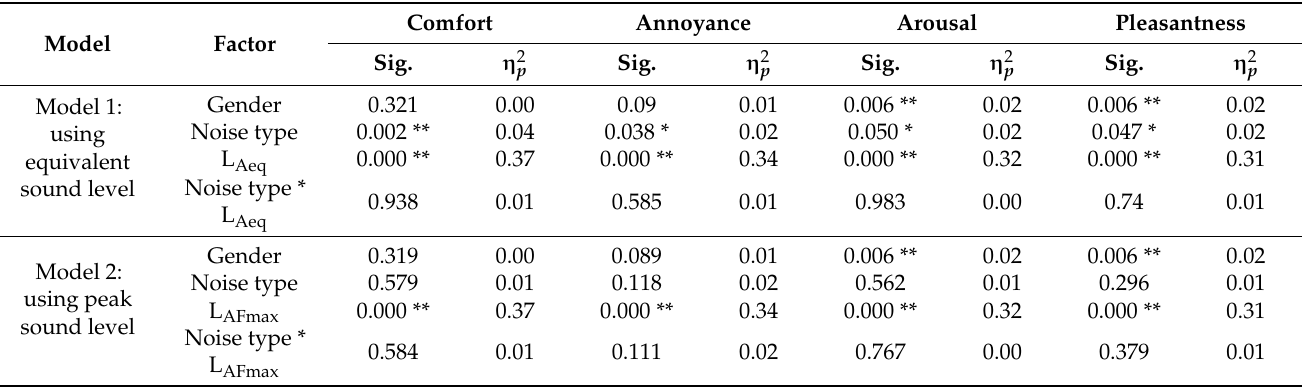
Table 1. Results of multivariate test of psychological evaluations of traffic sounds. * and ** represent significant differences at 0.05 and 0.01 levels, respectively. Sig. and η 2 p are the significance coefficient and effect size factor, respectively.